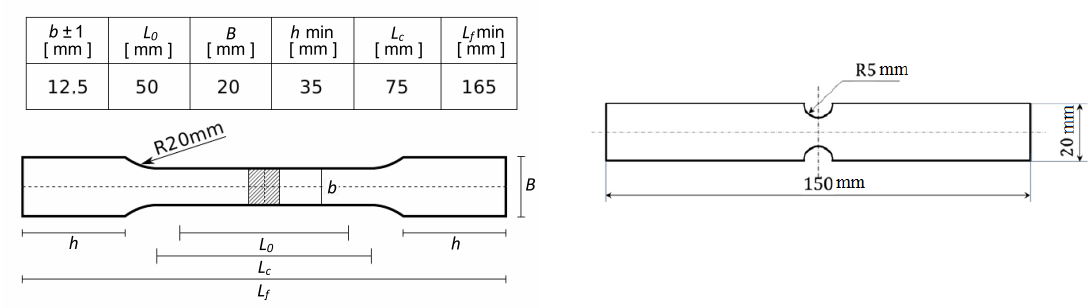
Figure 10. Geometry and dimension of the A50 ( left ) and notched ( right ) samples.